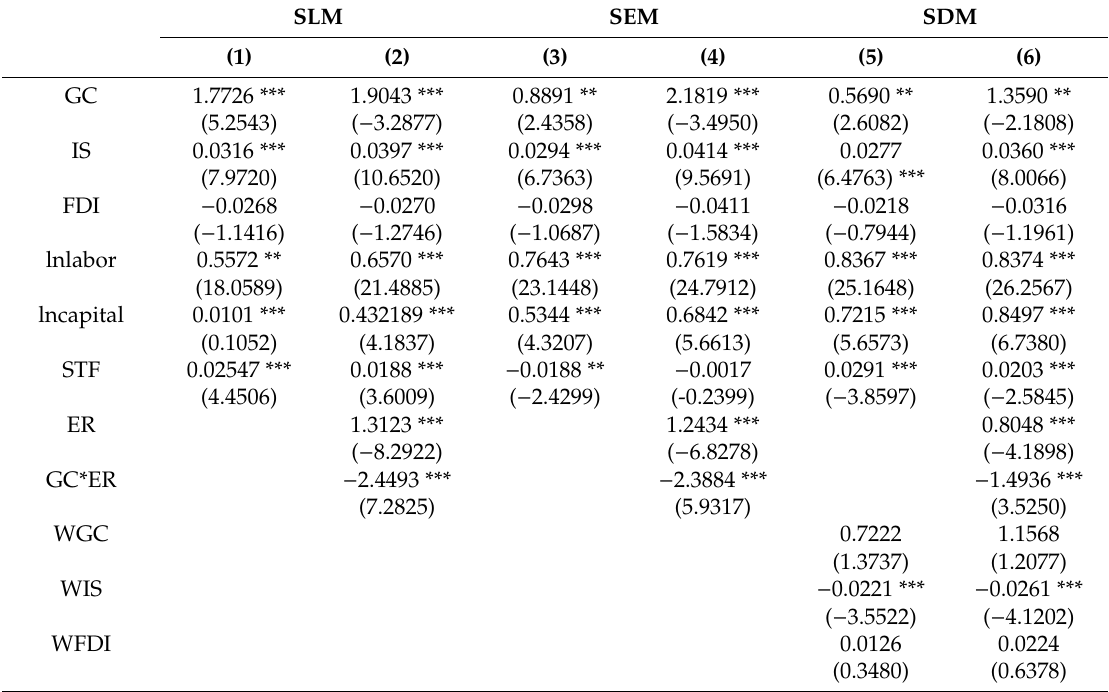
Table 5. Spatial panel model estimation results of influence factors of GTI in